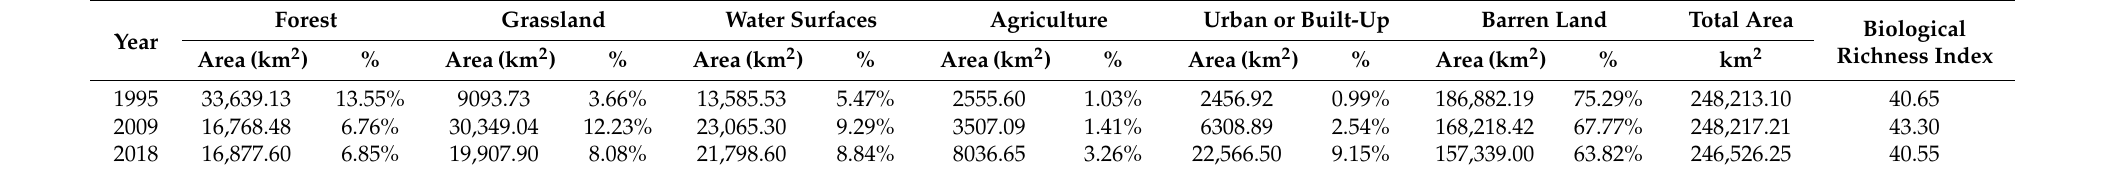
Table 5. Results of land use classification in Hetian.